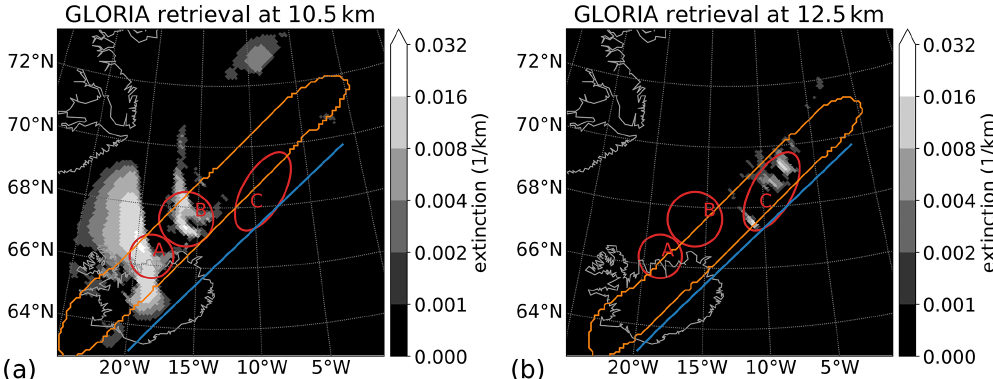
Figure 13. Cross sections of extinction retrieved from GLORIA measurements. Panel (a) shows a horizontal cross section at 10.5km and (b) one at 12.5km. The flight path is shown in blue; the trust region with high confidence in retrieval results around the tangent points of measurements is marked in orange. The three red ellipses mark areas of